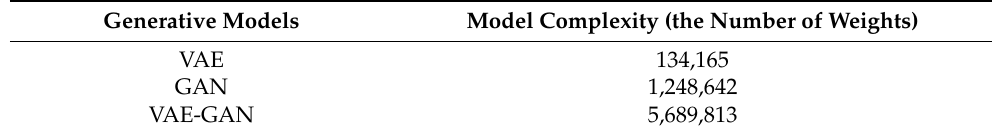
Table 6. Model complexity for various generative models.